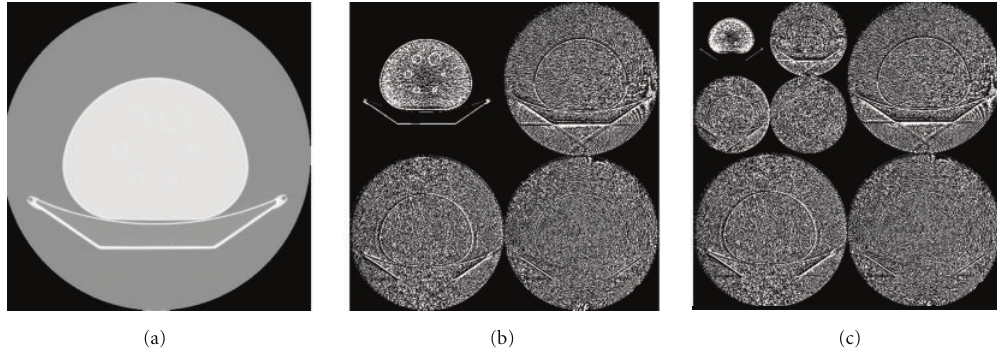
Figure 3: 2D-DWT. Original image (a), first decomposition level (b), and second decomposition level (c).